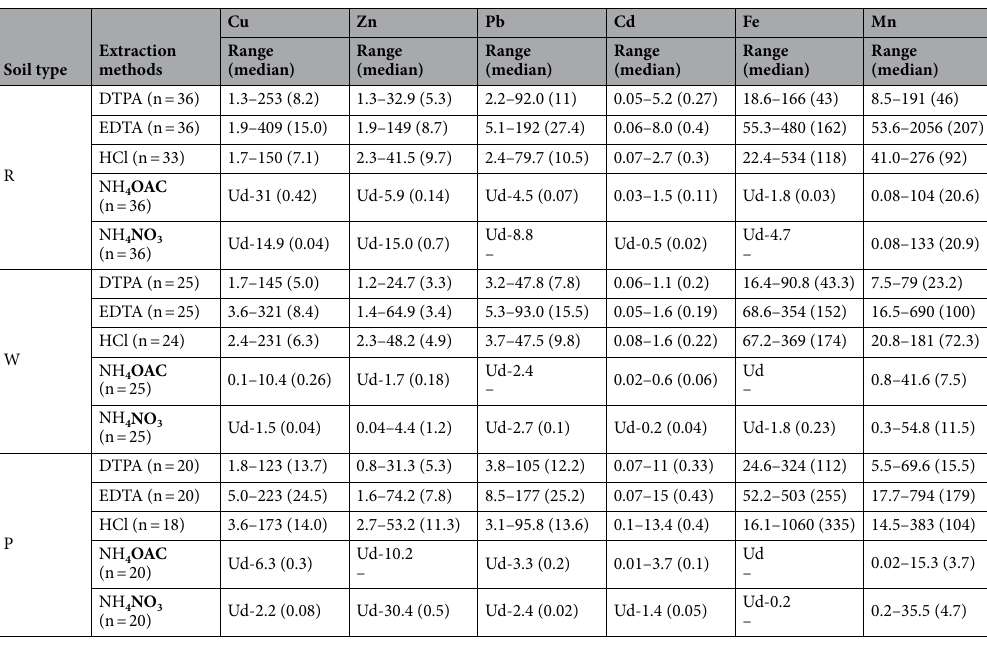
Table 3. Extractable metal concentrations in the soils (mg/kg). Ud under detection limit, – more than half of samples did not exceed the detection